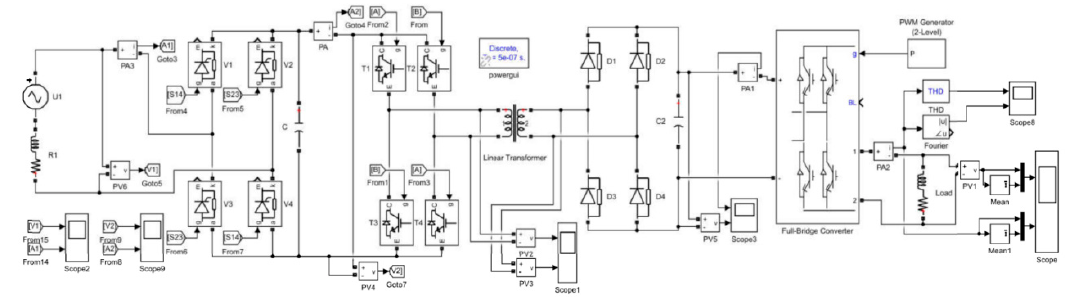
Figure 4. Simulink model of the single-phase solid-state transformer (SST).